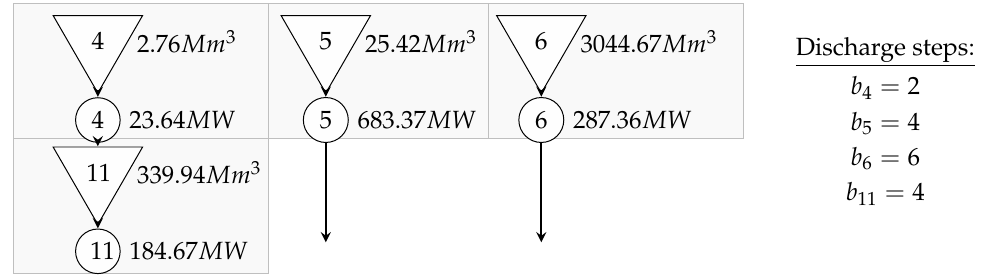
Figure 4. Simplified version of the Sira Kvina river basin.